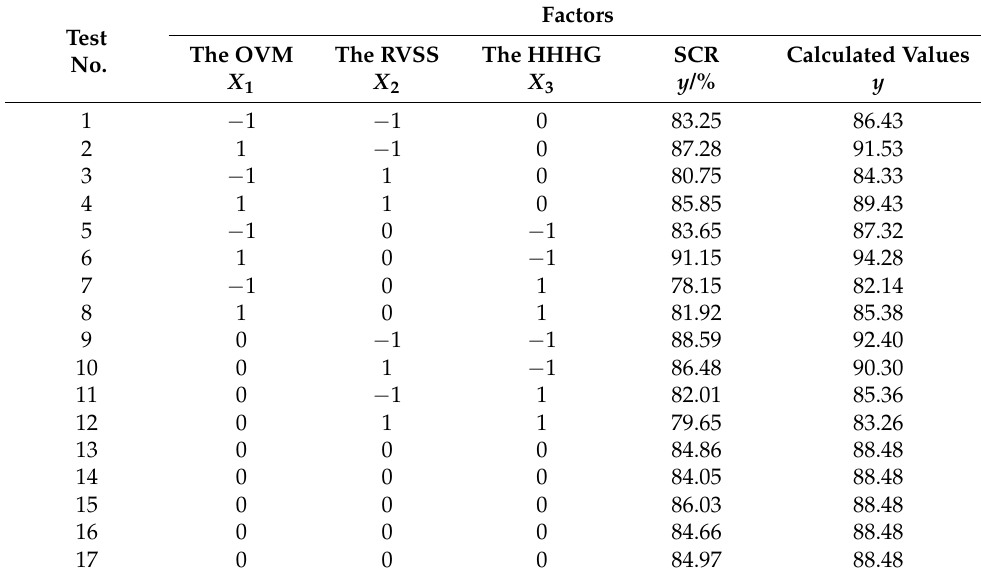
Table 3. Experimental design and